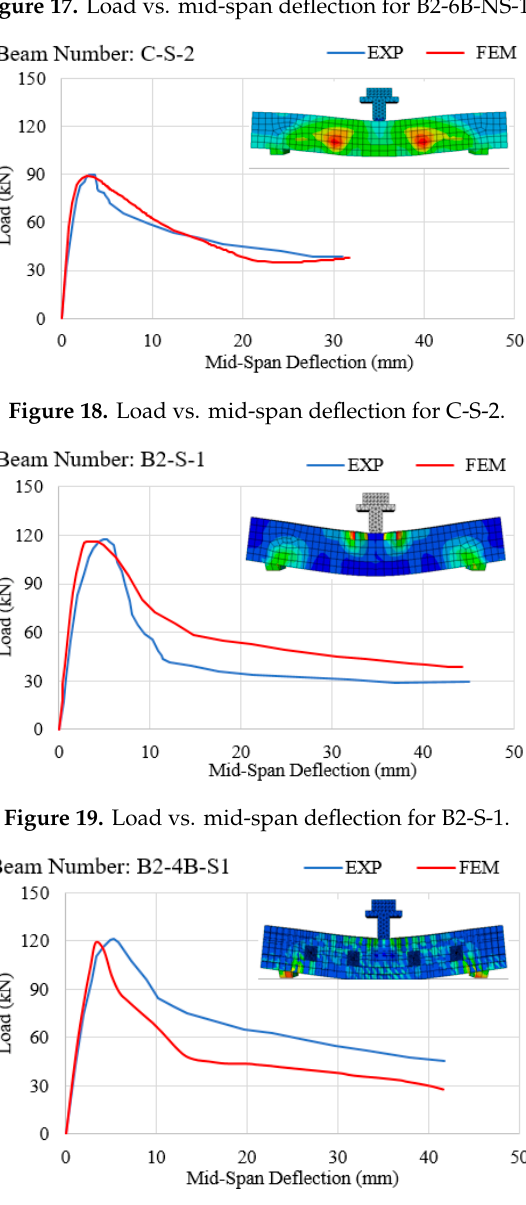
Figure 20. Load vs. mid-span deflection for B2-4B-S-1.